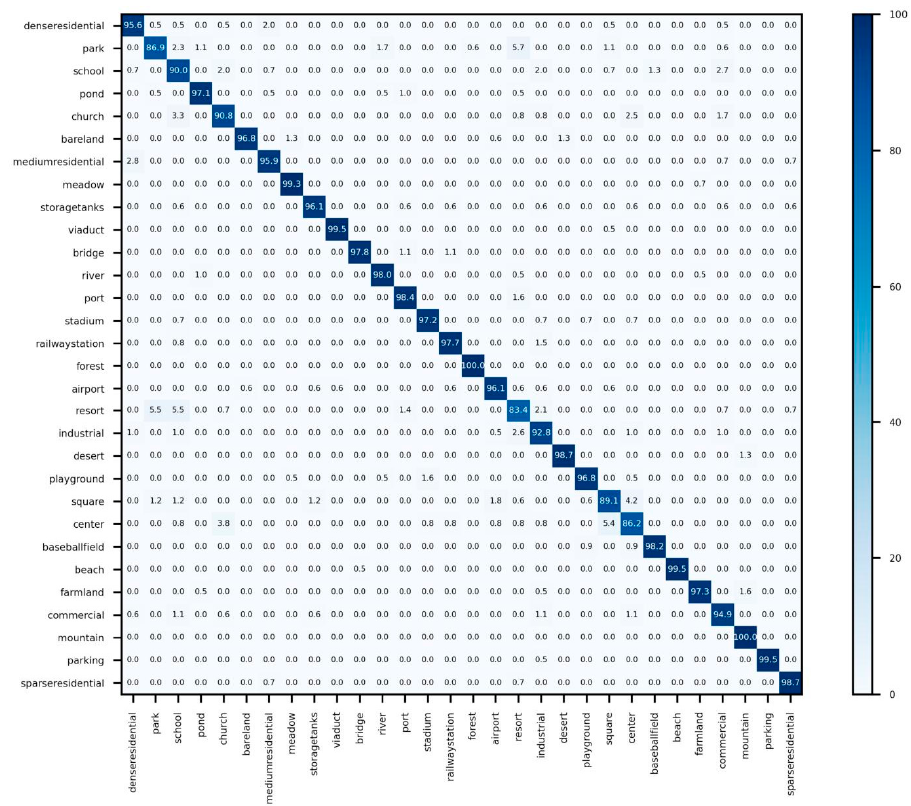
Figure 11. Confusion matrix of fine-tuned results on AID 50% training proportion.